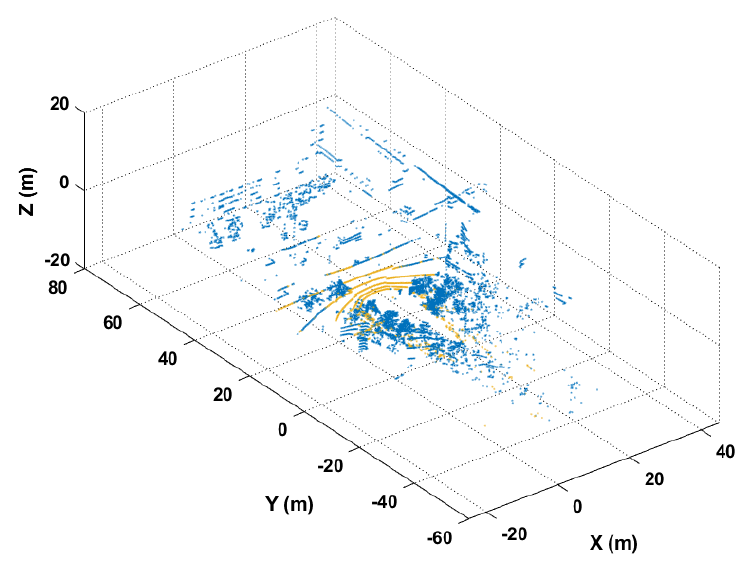
Figure 4. Ground Points Labeled in Yellow in the Point Cloud.